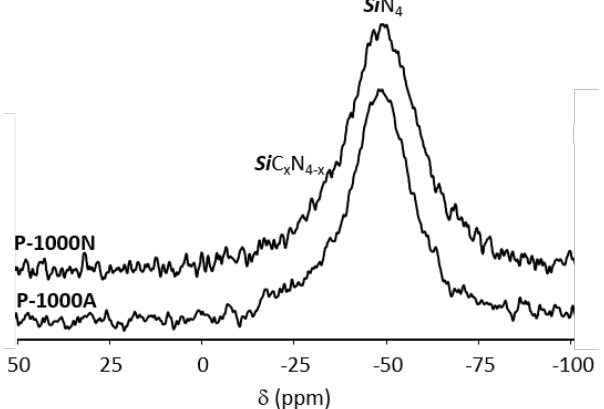
Figure 10. Experimental 29 Si MAS NMR for the pyrolysis samples isolated at 1000 °C in flowing argon and nitrogen at 7 T.